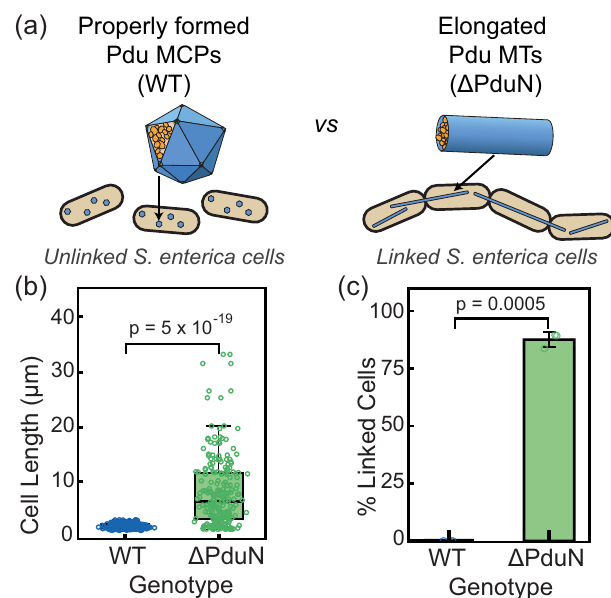
Fig. 6 The formation of Pdu MTs leads to a linked cell phenotype that allows distinction between cells expressing Pdu MCPs versus Pdu MTs. a Schematic of phenotypes associated with Pdu MCP and Pdu MT formation. b Box and whisker plot of length of cells expressing properly formed MCPs (WT) and cells expressing MTs ( Δ PduN). Cell measurements were made over three biological replicates, with a total of 171 WT cells measured and 121 Δ PduN cells measured. The p value displayed was calculated using a 2-tailed t test assuming unequal variances. Box extends from the fi rst quartile to the third quartile of the data, the line indicates the median, and whiskers extend from the box by 1.5 times the inter-quartile range. c Percentage of cells that contained 3 or more linkages (de fi ned as cell bodies split by a clear cleavage furrow) in MCP-forming (WT) and MT-forming ( Δ PduN) strains. Bars represent mean values of percentage linked cells over three biological replicates. Error bars represent standard deviation over three biological replicates. The p value dispayed was calculated using a 2-tailed t test assuming unequal variances. Source data for panels ( b ) and ( c ) are provided as a Source Data fi